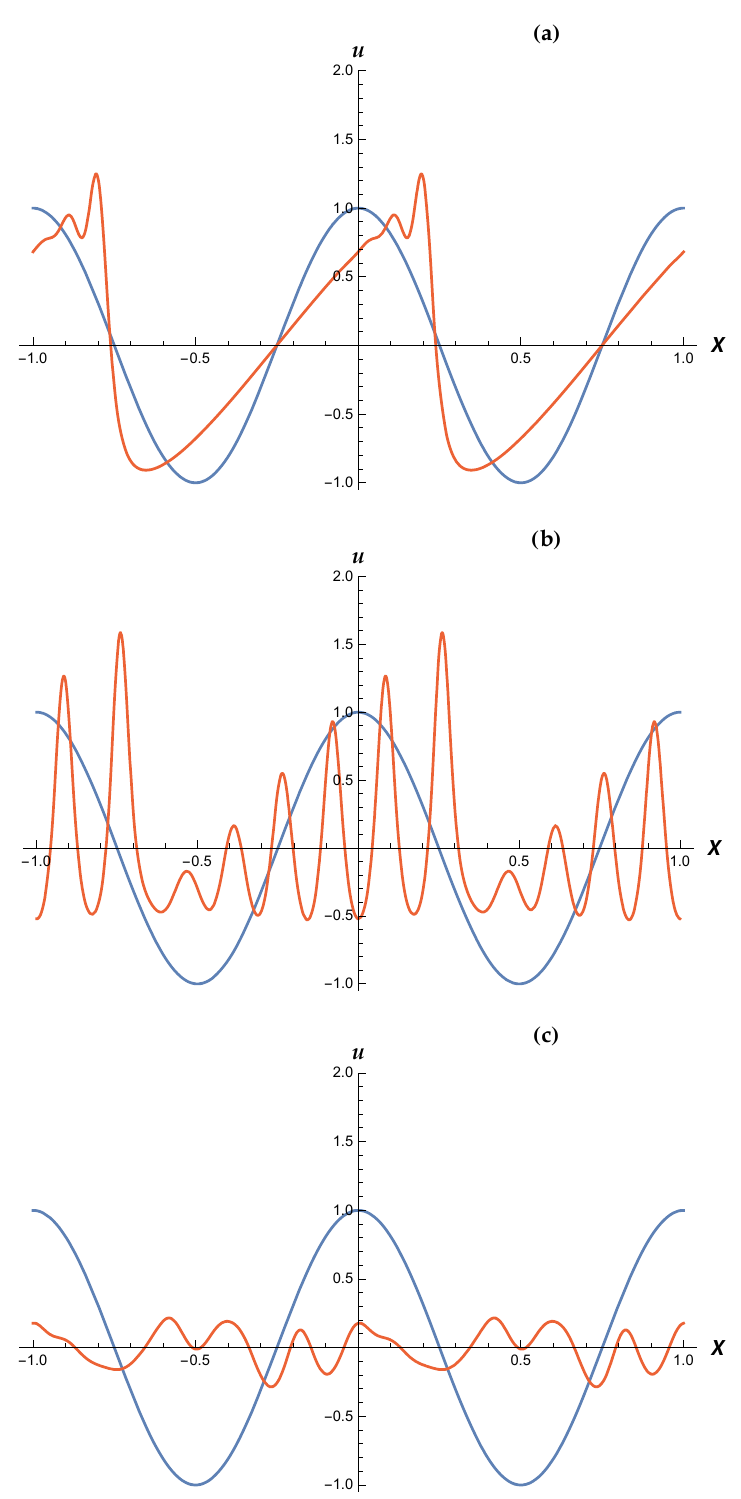
Figure 1. The dKdV case of IBVP (30). ( a – c ) correspond to T = T ∗ ≈ 1.382. Red curves: u vs. X for a T ∗ B curves: IC given in Equation